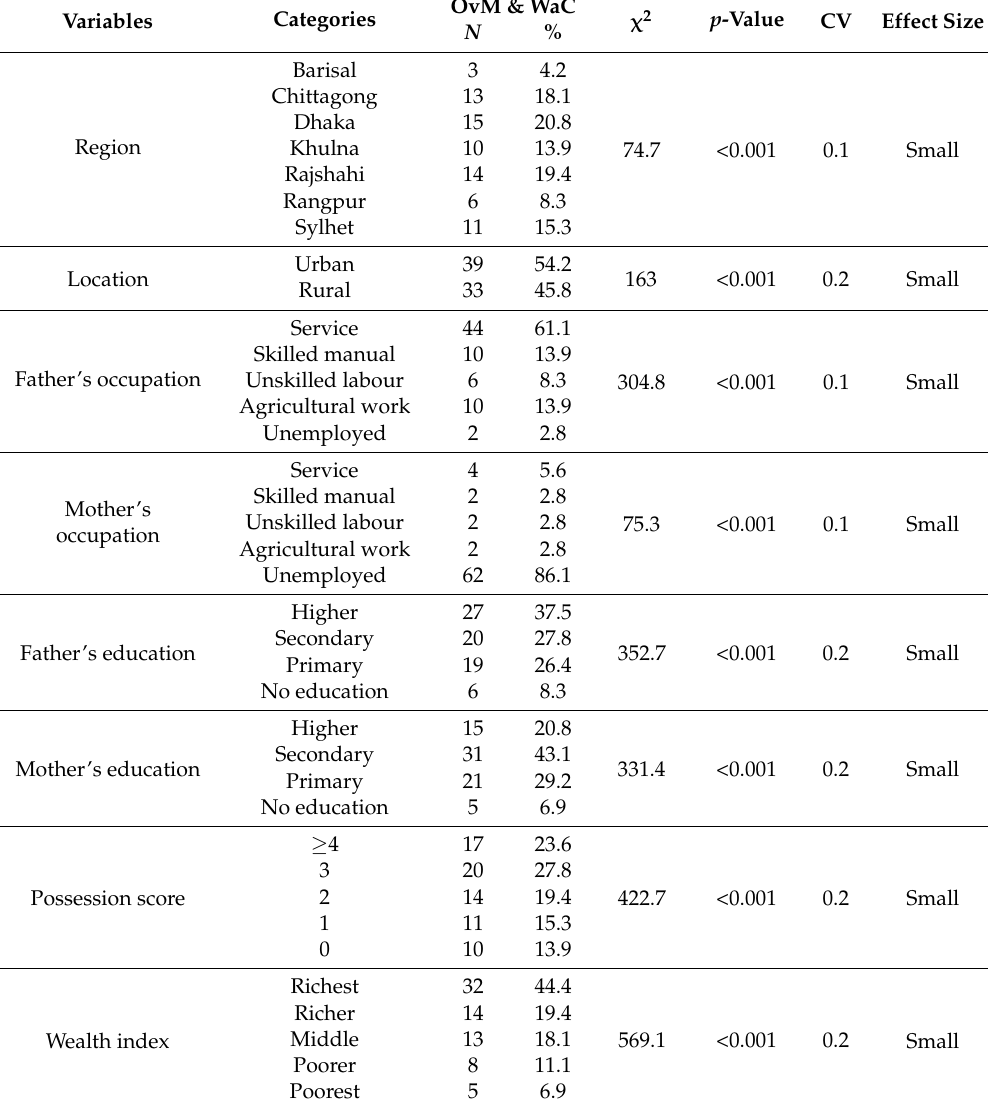
Prevalence of overweight mother and wasted child pairs through the socio-demographic